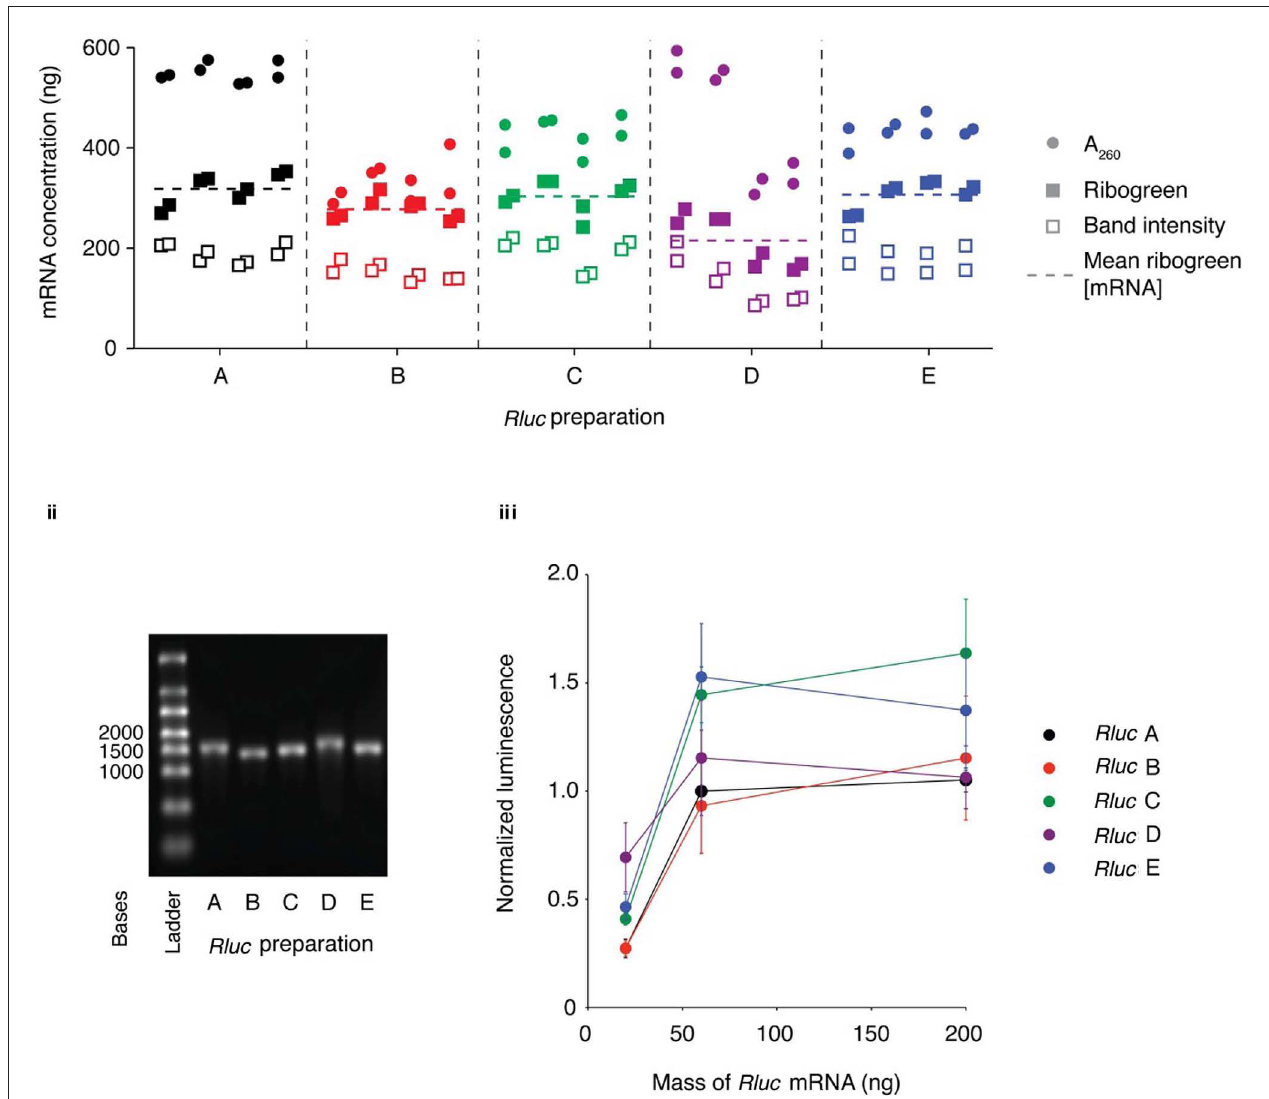
stained-gel (Gel intensity ¨ ). Concentrations were measured in duplicate on four Figure S3 | Assessment of the consistency of Rluc mrNA preparations. different occasions. The mean Rluc concentration, as measured by Ribogreen, is The consistency of luciferase expression from mRNA preparations transcribed represented by a dashed line (- - -). (ii) A representative ethidium bromide- from the same template was investigated. (i) Measurement of Rluc mRNA stained gel containing the five Rluc mRNA preparations (A–E) and the RNA concentrations using three different methods. Each section of the chart (A–E) mass ladder from which the mass of the Rluc preparations were calculated. (iii) represents a different Rluc mRNA preparation. Different colors represent Graph showing luciferase activity of lysates from DRG neurons transfected with different mRNA preparations and are consistent throughout all parts of the 20, 600, and 200 ng of the five Rluc mRNA preparations (A–E). Data were figure. The concentration of each Rluc mRNA preparation was determined using l ), a fluorescent dye-based solution method normalized to luciferase activity of neurons transfected with 100 ng of Rluc the absorbance at 260 nm (A 260 mRNA preparation A ( n = (Ribogreen; n ), and by measuring the intensity of a band in an ethidium bromide